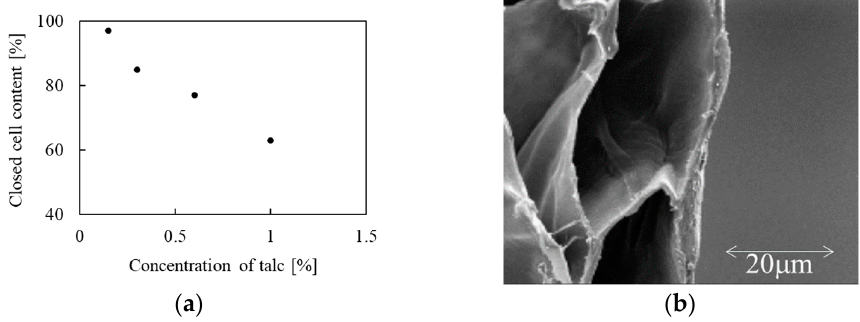
Figure 4. ( a ) Closed cell content as function of talc content, ( b ) cell wall thickness detail.